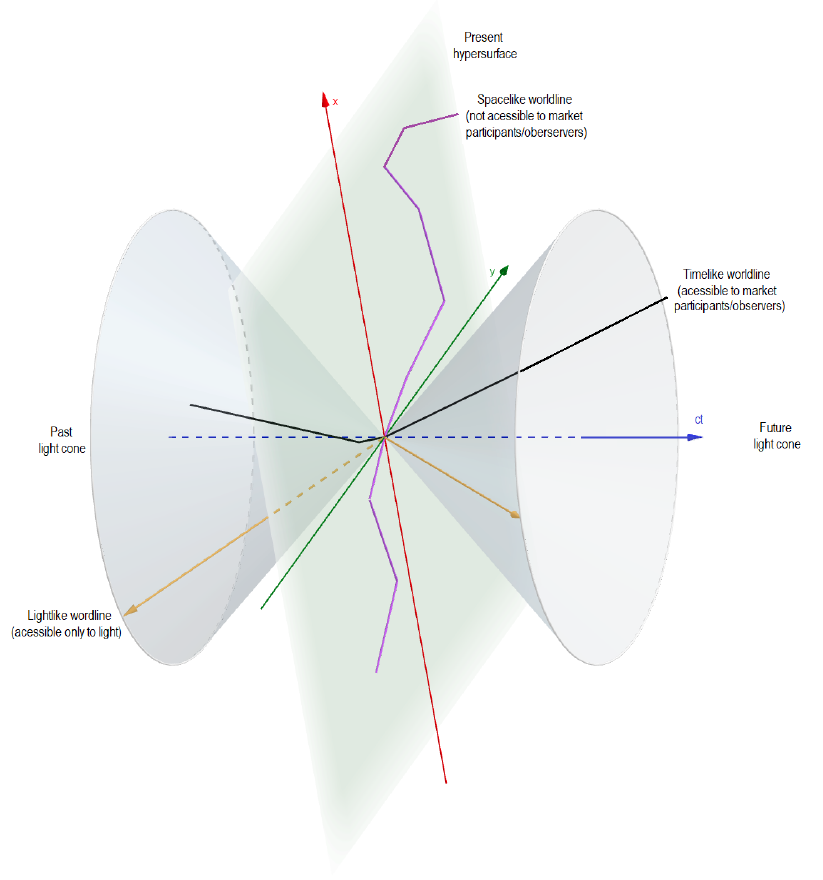
Figure 1. A spacetime diagram with past and future light cones and timelike, lightlike and spacelike trajectory